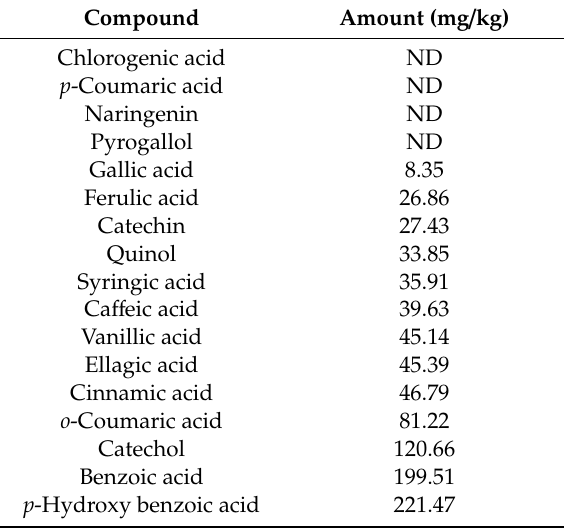
Table 2. Polyphenolic compounds identified in the ethanol extract of the Haplophyllum tuberculatum whole plant by High Performance Liquid Chromatography